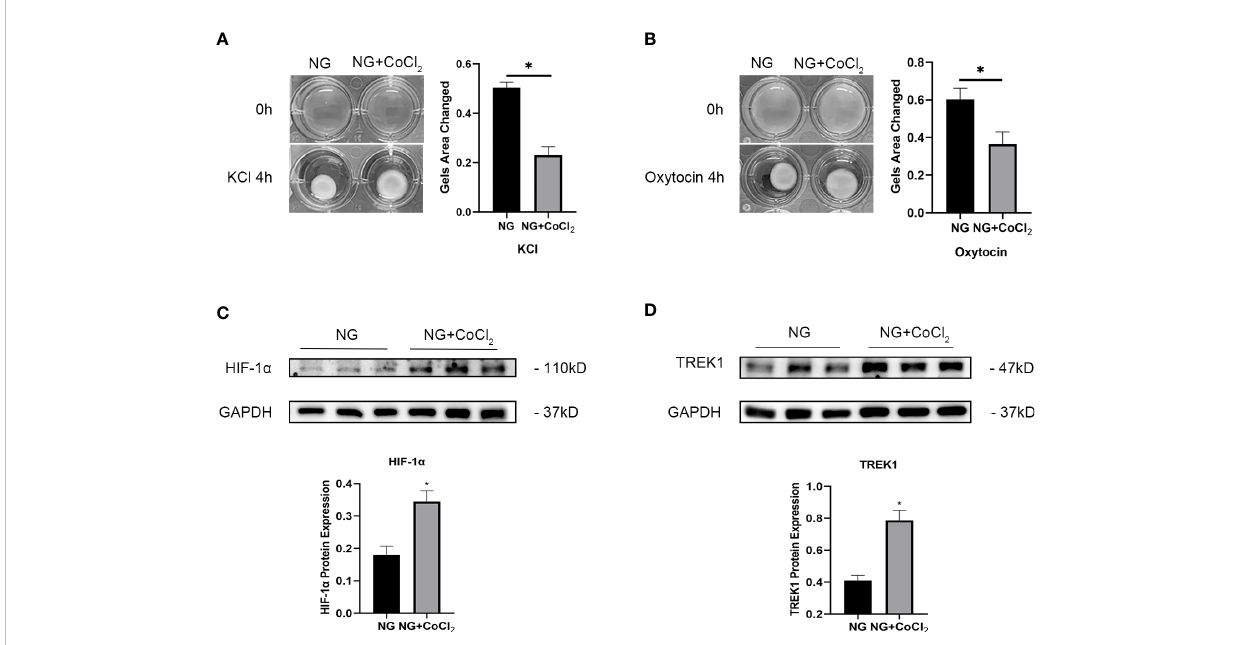
FIGURE 4 Induced cell hypoxia decreased the contraction and increased TREK1 protein expression in HUSMCs. HUSMCs mixed with collagen were cultured in normal glucose (5.5 mmol/L) (NG) medium and normal glucose with CoCl 2 medium (NG+CoCl 2 ), which induced hypoxia in a 24-well plate. The medium was added after collagen polymerization (0 h). The images of collagen stimulated by KCl (A) or oxytocin (B) for 4 h. The contraction of HUSMCs was assessed by measuring the mean gel area change. The HUSMCs of each group were fi rst cultured in NG medium, and the NG + CoCl 2 group was replaced with NG + CoCl 2 medium for 24 h when the cell density reached 60% – 70%. Then, the total protein of each group was extracted, and HIF-1 a (C) and TREK1 (D) protein expression was measured by western blot analysis. Data are presented as means ± SEM, n = 4 for each group. * means NG+CoCl 2 vs. NG and P<0.05. HIF-1 a , hypoxia-inducible factor-1 alpha; HUSMCs, human uterine smooth muscle cells; SEM, standard error of the mean; TREK1, TWIK-1-related potassium